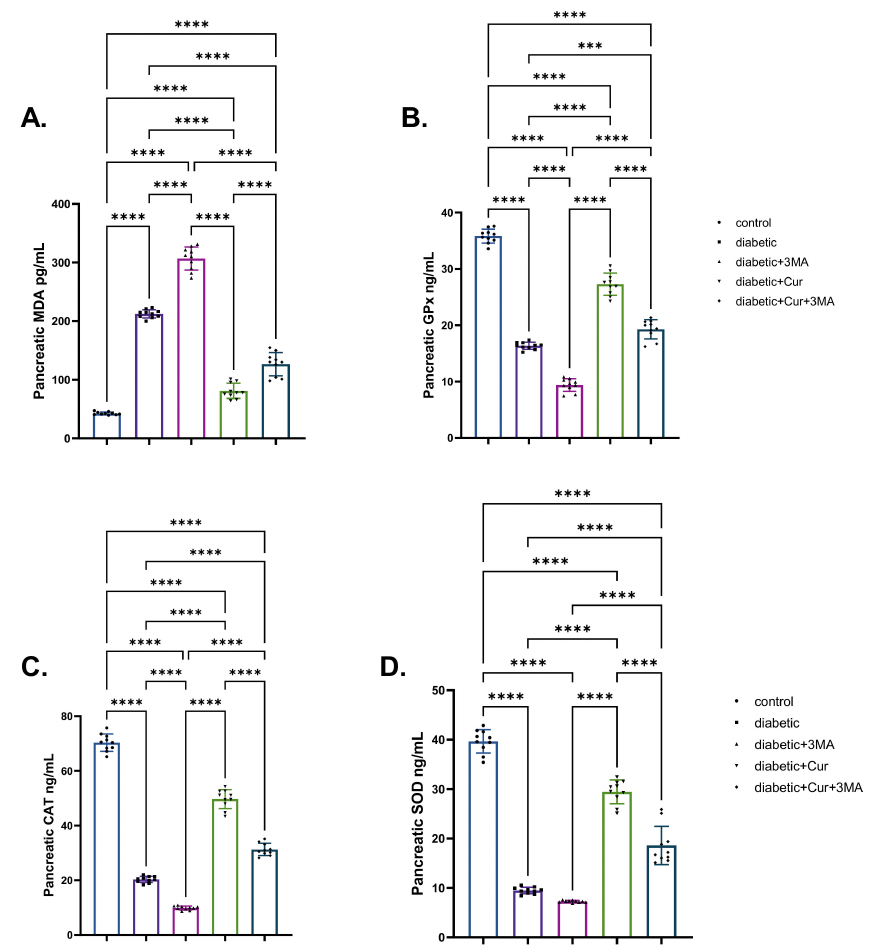
Figure 3. Effect of diabetes (STZ) (65 mg/kg b.wt), 3MA (10 mg/kg b.wt), LPs-CUR (10 mg/kg b.wt.) oral dosing for 10 weeks on ( A ) MDA., ( B ) GPX., ( C ) C.A.T., ( D ) SOD. in pancreatic tissue of all diabetic and vehicle control groups. Data expressed as mean ± SE, n = 10 for each group. Each bar carrying the significance which may be significant at *** means when p < 0.001 and **** p < 0.0001 at p <